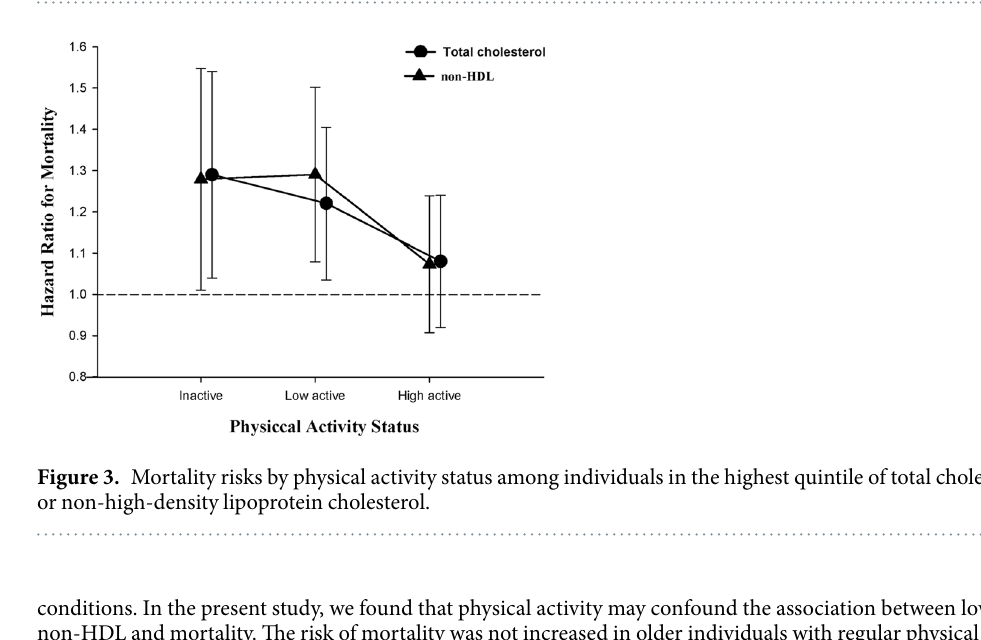
6 Scientific RepoRts | 7: 8399 | DOI:10.1038/s41598-017-07857-7